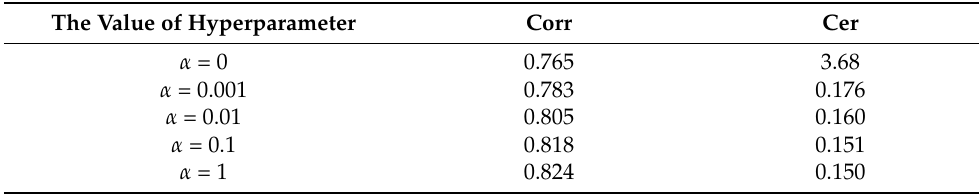
Table 8. The impact of the CTC loss on PSCPSF dataset.